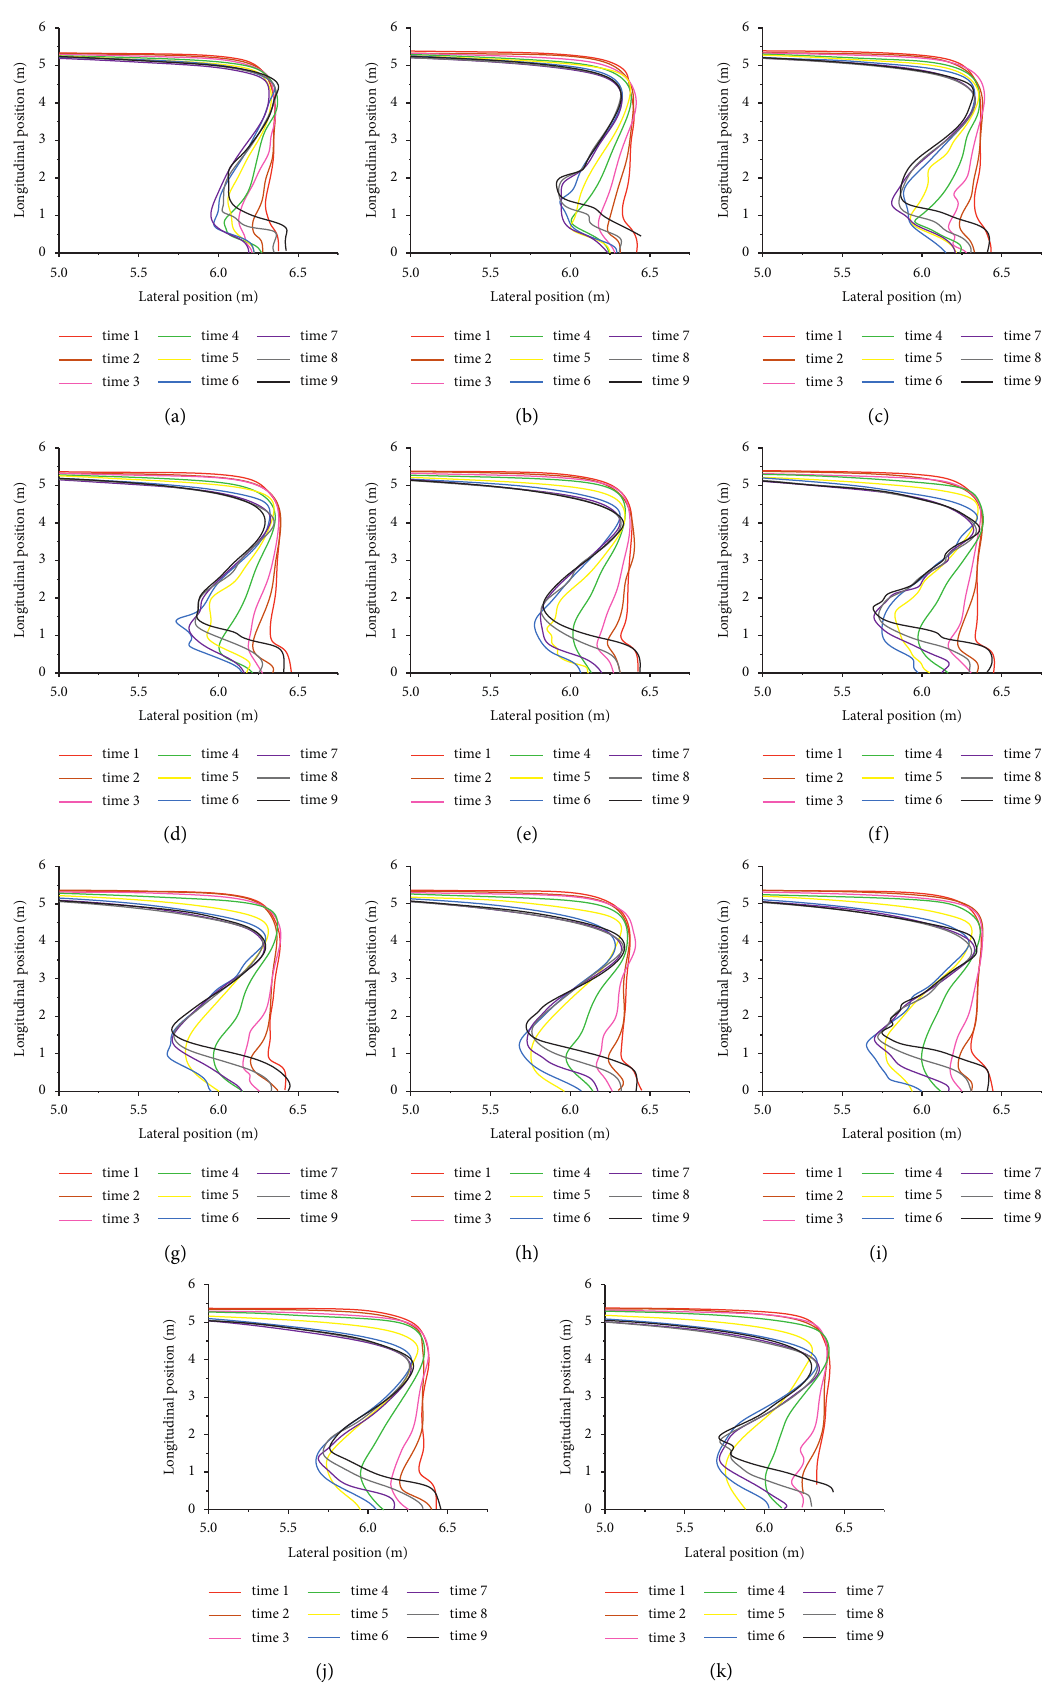
Figure 5: The coal gangue boundary curve at different times. (a) The boundary curve at 20 ° . (b) The boundary curve at 22 ° . (c) The boundary curve at 24 ° . (d) The boundary curve at 26 ° . (e) The boundary curve at 28 ° . (f) The boundary curve at 30 ° . (g) The boundary curve at 32 ° . (h) The boundary curve at 34 ° . (i) The boundary curve at 36 ° . (j) The boundary curve at 38 ° . (k) The boundary curve at 40 °